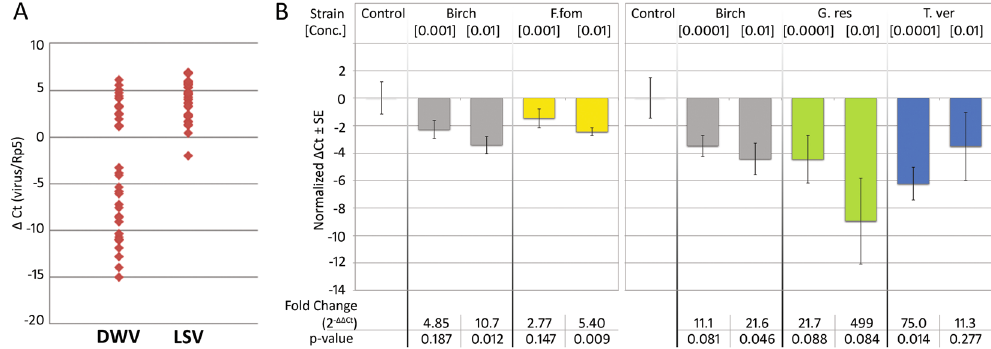
Figure 2. Lake Sinai virus (LSV) is reduced by fungal extract treatments. ( A ) All 36 individual bee abdomens from our source population tested positive for both DWV and LSV. LSV was more highly expressed than DWV, and more highly expressed than the honey bee RpS5 reference gene. ( B ) Fungal extracts reduced LSV titers in bees after 7 days of treatment. F. fomentarius significantly reduced LSV at a 1% dosage (2-tailed t-test, n = 8, t = 3.96, p = 0.009, ΔΔ Ct fold change = 5.40). The greatest fold change difference was seen with G. resinaceum